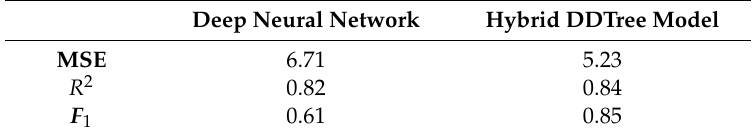
Table 3. Results of depth classification: mean square error (MSE) and coefficient of determination ( 𝑅 2 ).